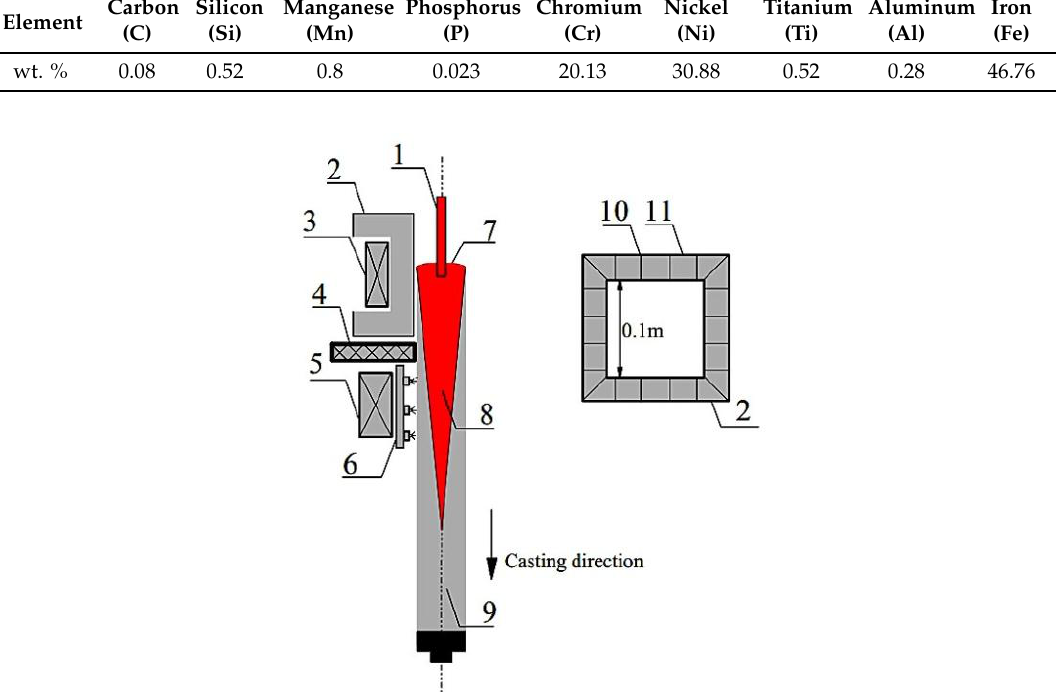
Table 1. Chemical composition for the Incoloy800H superalloy (in wt. %). Carbon Silicon Manganese Phosphorus Chromium Nickel Element